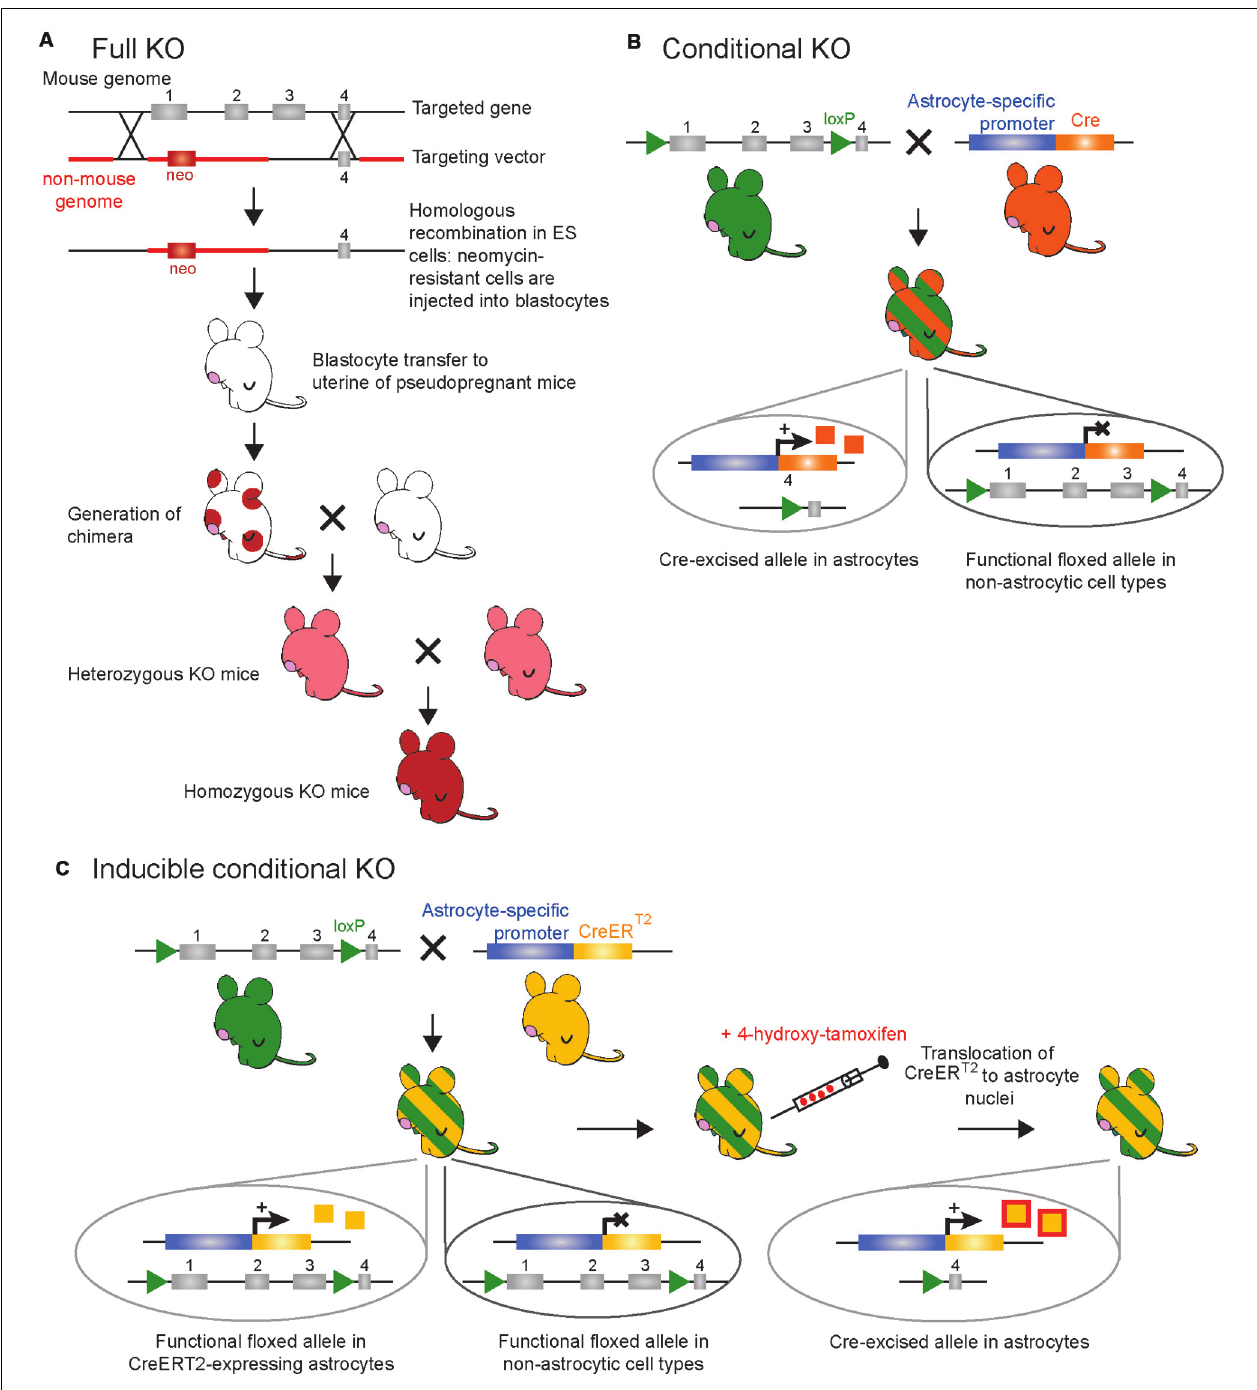
pseudopregnant females where they can differentiate into all cell types of a chimeric mouse (red circles). After breeding the chimeric mice, the resulting offspring will derive from the ES cells – as seen with the transmission of coat color (red) – if the introduced ES cells become established into the germline of the chimeric mouse. In the full KO, the gene of interest is knocked out in all cell types (not only astrocytes) of the offspring. (B) Classical Cre- LoxP strategy for conditional gene knockout.The creation of two mouse lines is necessary. First, a floxed mouse line (green) is obtained by homologous